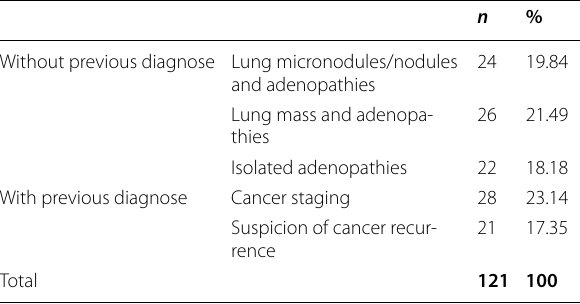
Table 4 Motives for EBUS execution